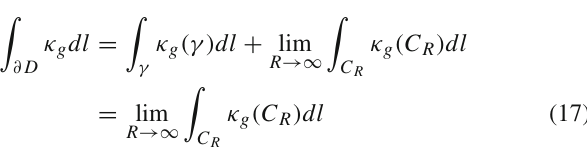
(cid:17) κ g dl ischosen ∂ D